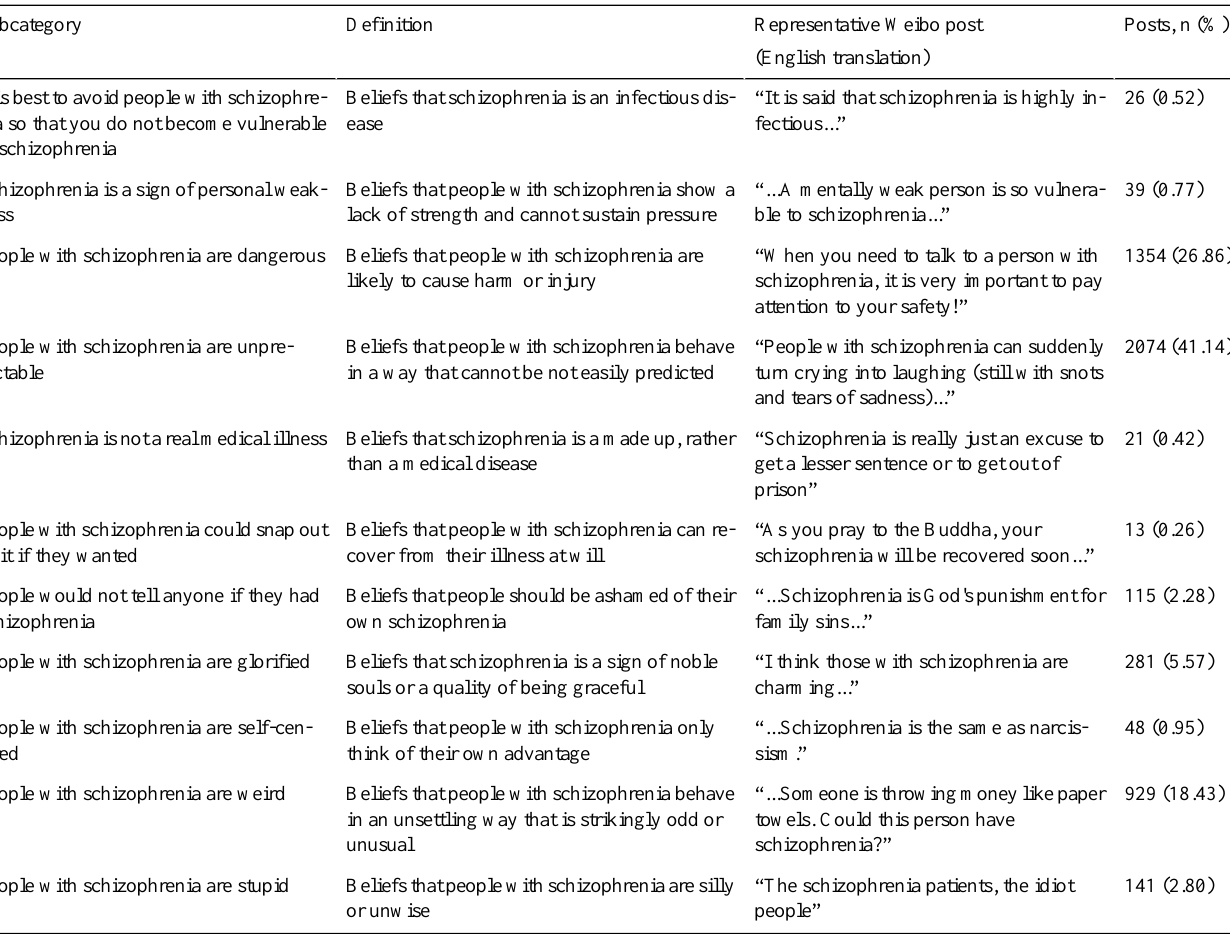
Table 2. Coding framework for schizophrenia-related